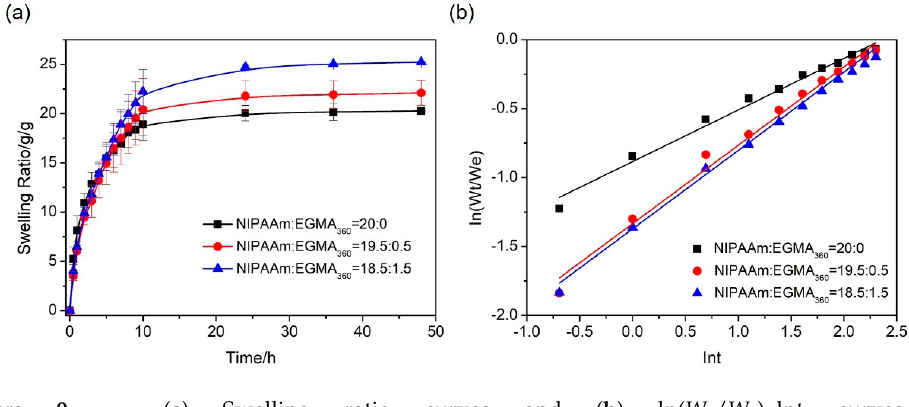
Figure 9. ( a ) Swelling ratio curves and ( b ) ln( W t / W e )–lnt curves of alginate-Ca 2+ /P(NIPAAm- co -EGMA 360 ) hydrogels in water at 25 °C. The monomer ratios of NIPAAm to EGMA 360 are 20:0, 19.5:0.5, and 18.5:1.5.